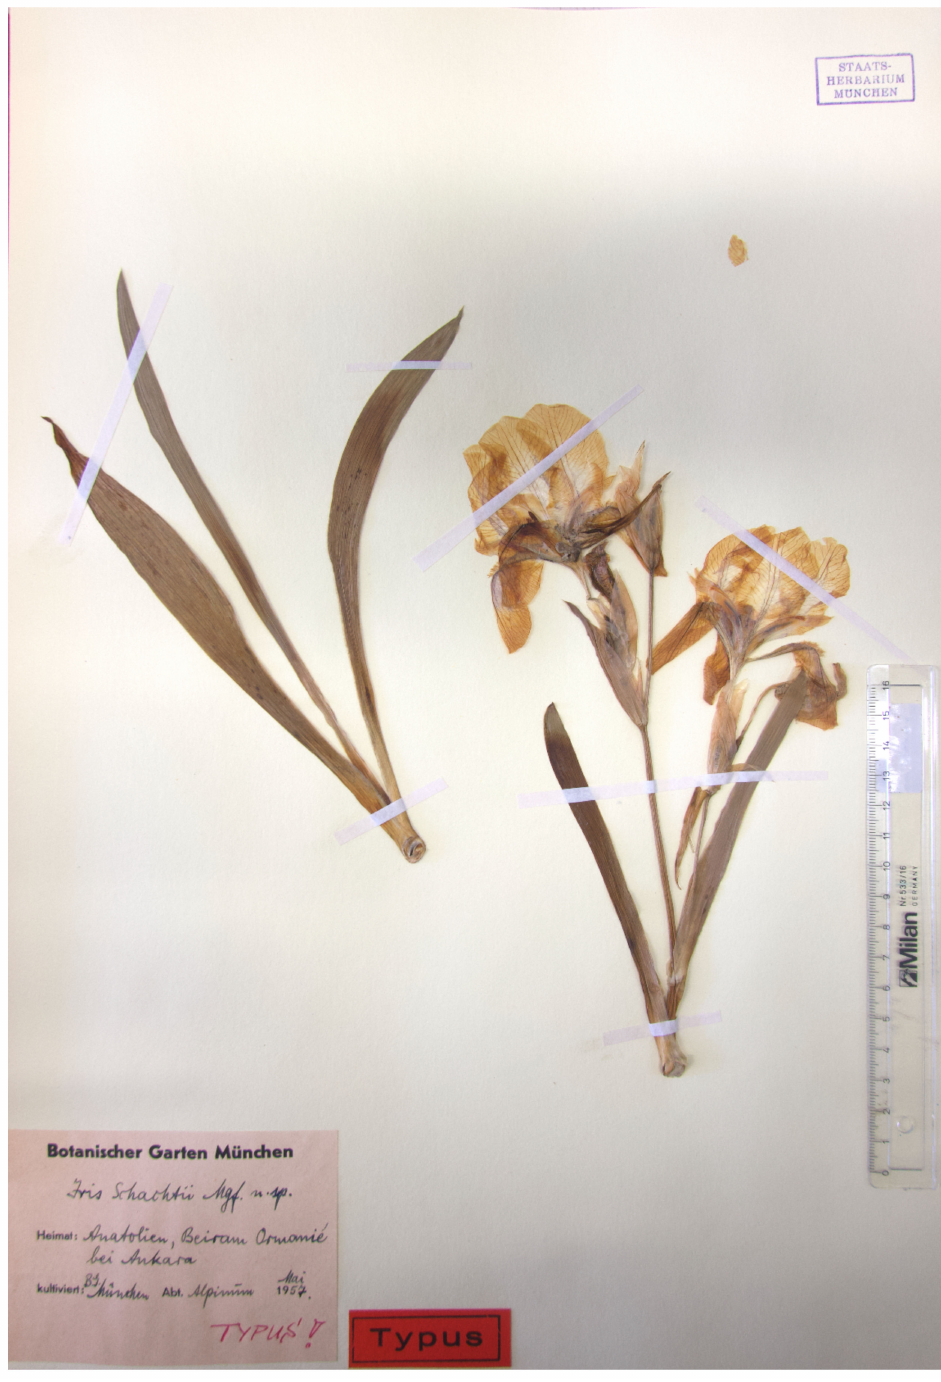
Figure 8. Lectotype of Iris schachtii (M), by permission of the